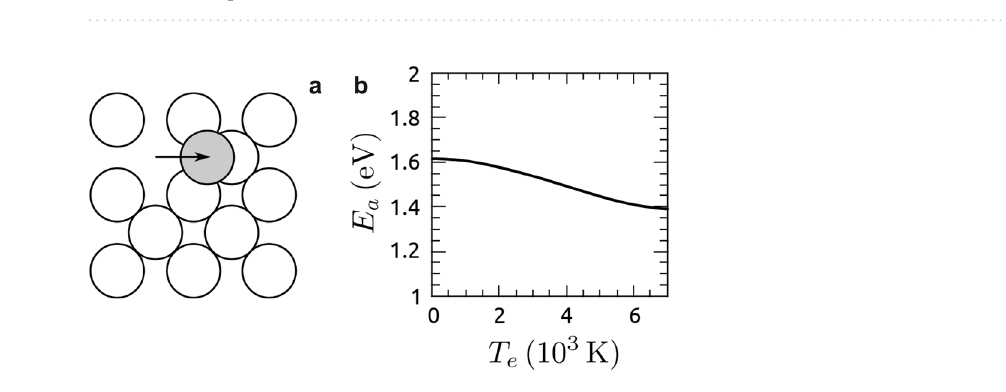
Figure 8. Critical fluence for bulk diffusion: ( a ) The critical absorbed SPP fluence F c required to induce thermal bulk diffusion of an interstitial or vacancy as a function of the activation energy E a associated with moving said particle ( b ) The fraction of particles within a small subsurface layer expected to diffuse to the surface over the course of the experiment as a function of the absorbed SPP fluence.